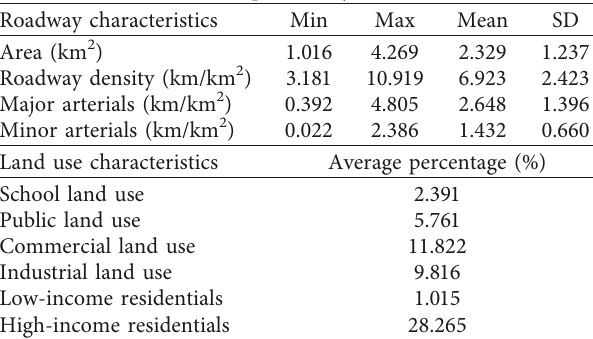
Figure 2: Final NC partitioning results. Table 1: Descriptive analysis of 13 NCs.